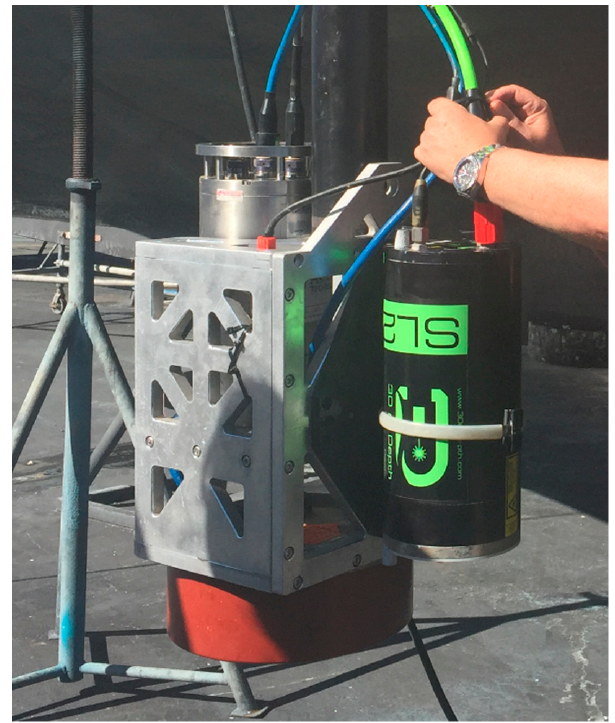
Figure 2. View of the mounting system showing the 3DAD SL2 unit, the ROVINS, and the sonar transducer.